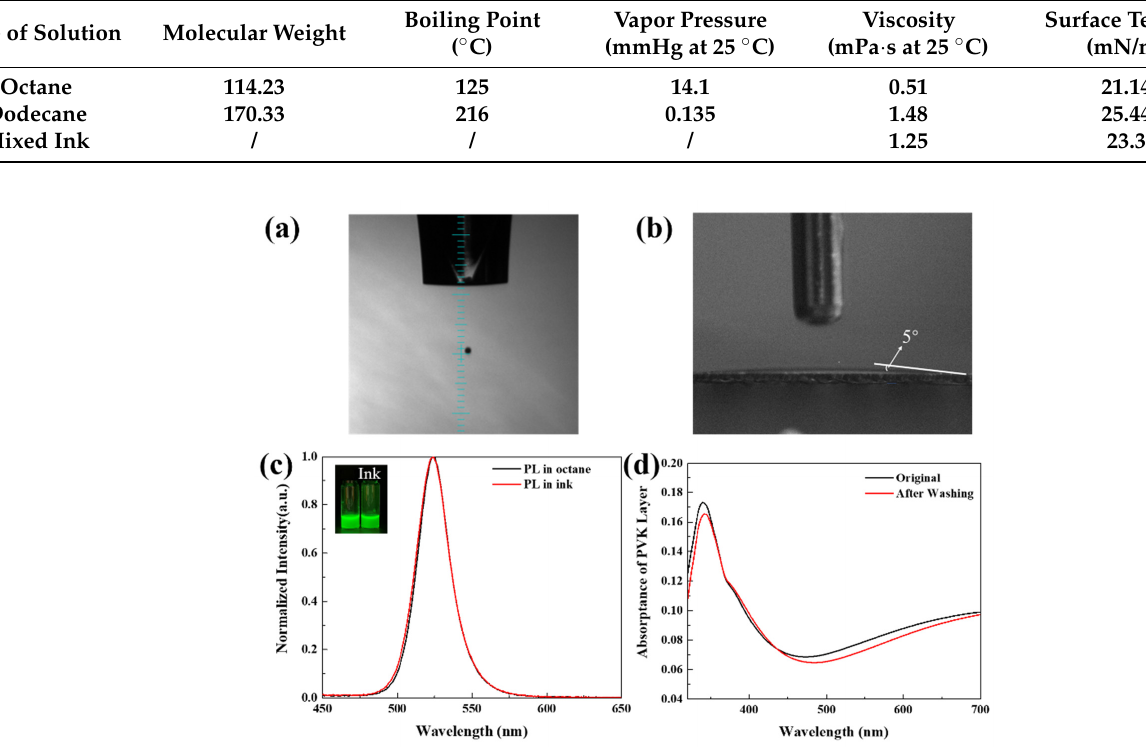
Figure 1. ( a ) Stable perovskite nanocrystal ink droplet existing from the nuzzle; volume of the droplet was around 60 pL; ( b ) contact angle of a perovskite nanocrystal ink drop on the PVK layer; ( c ) the PL spectra of the perovskite nanocrystal in octane and ink, with the inset showing the yellow-greenish images of the two samples under the excitation of 365 nm ultraviolet light; ( d ) ultraviolet–visible absorptance spectrum of initial and ink without perovskite nanocrystal washed PVK layer. To fabricate a perovskite nanocrystal film of high quality via inkjet printing, the cof- fee-ring effect during evaporation of the solvent should be solved. As shown in Figure 2a, in the drying process of a single droplet on the substrate, the evaporation speed of solvent at the edge of the droplet is different from the evaporation speed in the center [34], and the solute (perovskite nanocrystal) flows to the edge via capillary flow to form a rough surface, which is called the coffee-ring effect. To suppress the coffee-ring effect, the bal- ance between the capillary flow and Marangoni flow has been investigated in our previ- ous work [31]. A high-viscosity ink causes a weak capillary flow, which can suppress the migration of nanocrystal to the edge. In our binary solvent ink, the introduction of octane adjusted the viscosity to an optimal value, corresponding to a Marangoni flow that would simply offset the capillary flow to suppress the coffee-ring effect, due to the surface ten- sion gradience on the surface of the droplet [31,35,36], which is because of the difference in surface tension of octane and dodecane, as shown in Table 1. Meanwhile, according to a simulation conducted by Park et al. [34], the small contact angle of the droplet on the PVK layer also suppressed the coffee-ring effect, because the droplet with a smaller con- tact angle spread more widely, and the solvent evaporated faster under high-vacuum post-treatment. As shown in Figure 2b, we printed a perovskite dot array on a multilayer substrate, which was fabricated via spin-coating PEDOT: PSS and PVK with a MoO 3 in- terface layer via thermal evaporation on the patterned ITO glass, and the fabricated sub- strate can be directly used for PeLED devices. After inkjet printing, the samples were transferred into a high vacuum (<10 − 4 pa) chamber to remove the solvent. After vacuum annealing for 20 min, the coffee-ring-free and uniform dots array was formed, with a di- ameter of about 150 μ m, as shown in Figure 2c. Every single dot connected with the ad- joining dots when the spacing was reduced, to form a pinhole-free and uniform perovskite film.